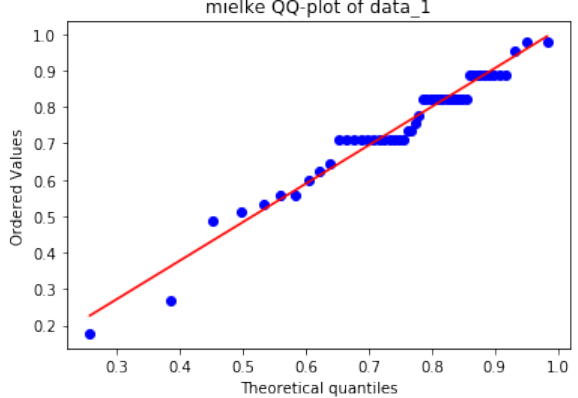
Figure 5. quantile – quantile plot for BCG Strains Dataset.